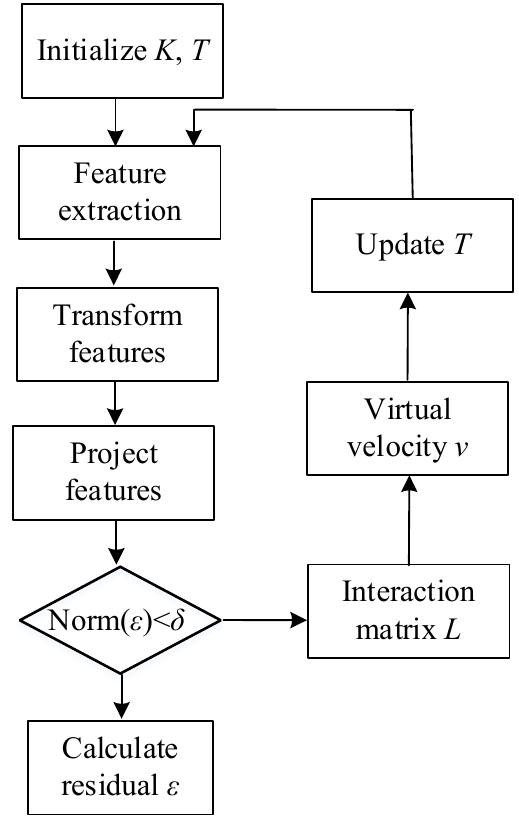
Figure 9. Algorithm of the VVS method. The mobile-robot system is divided into non-platform and platform parts. The non- platform part has two arms as two end-effectors, which use six variables to represent the position and orientation of each end-effector, and eighteen joints as active frames, as shown in Equations (10a) and (10b). The other is the mobile platform, a non-holonomic constraint created in Equations (11a) and (11b).